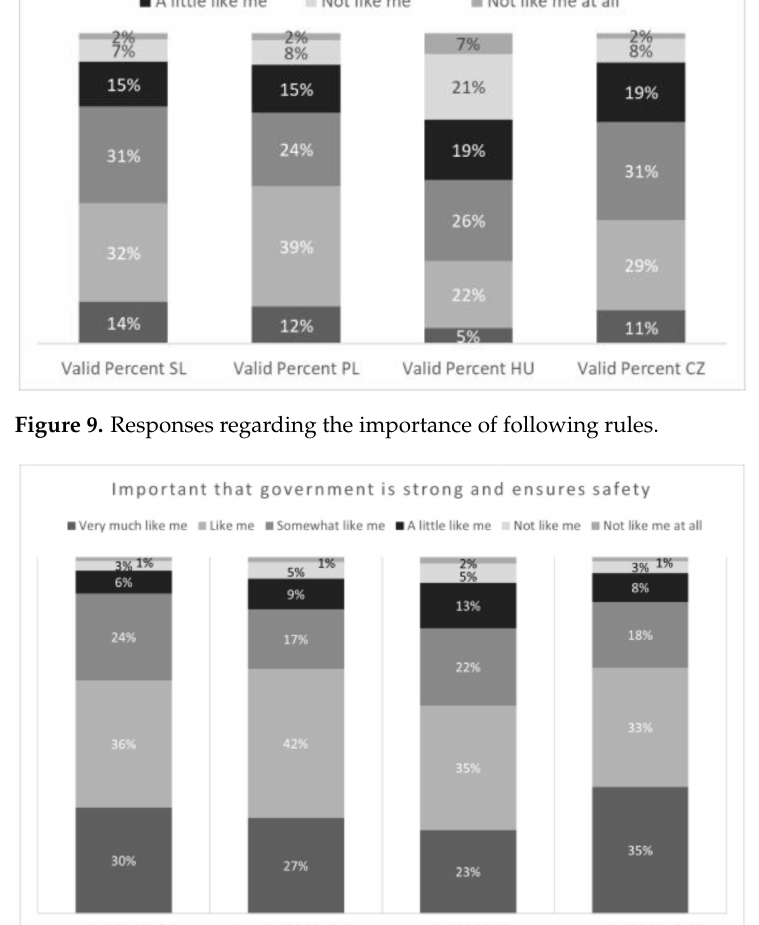
Figure 10. The governments’ role in ensuring